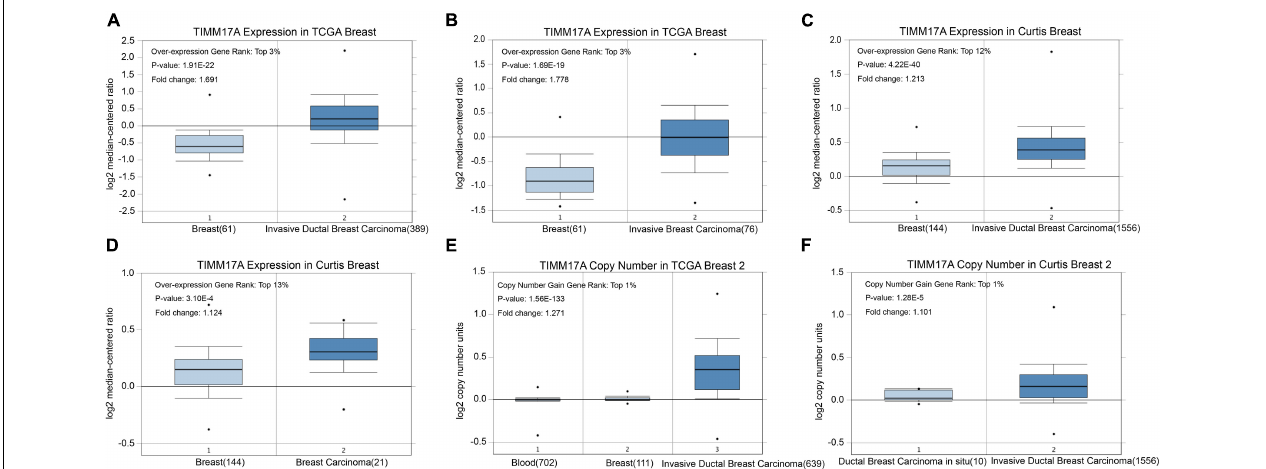
FIGURE 1 | TIMM17A transcription in breast carcinoma (Oncomine TM ). Levels of TIMM17A mRNA and DNA copy number were significantly higher in breast carcinoma than in normal tissue. Shown are fold change, associated p values, and overexpression rank based on Oncomine TM analysis. (A–D) Box plots showing TIMM17A mRNA levels for The Cancer Genome Atlas (TCGA) Invasive Ductal Breast Carcinoma, TCGA Invasive Breast Carcinoma, Curtis Invasive Ductal Breast Carcinoma, and Curtis Breast Carcinoma datasets, respectively. (E,F) Box plots showing TIMM17A copy number in TCGA Breast 2 and Curtis Breast 2 datasets, respectively.